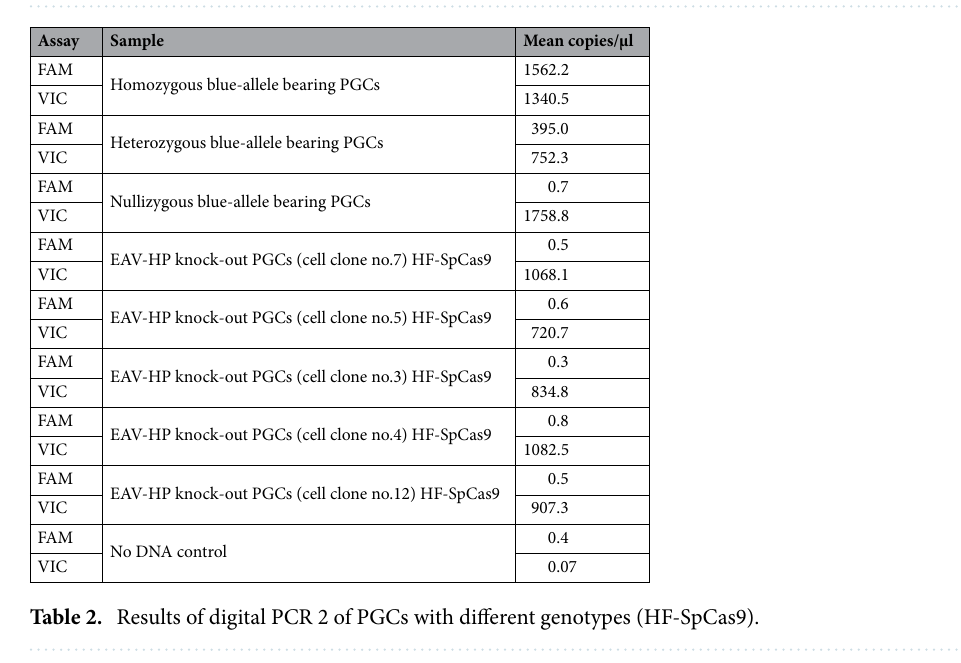
Figure 5. Digital PCR of homozygous blue-allele bearing PGCs and knock-out PGC clones (digital PCR 2). ( a,b,d,e ): blue: FAM reporter dye signal, red: VIC reporter dye signal, green: FAM/VIC reporter dye signals, yellow: no amplification (DNA-empty wells), VIC: reference assay (β-actin), FAM: digital PCR 2 assay. ( a ) Two- dimensional scatterplot of digital PCR duplex assay (FAM/VIC) and ( b ) histogram from PGCs (homozygous blue-allele bearing PGCs); ( c,f ) chip view by calls (uniformity), ( d ) scatterplot of digital PCR duplex assay (FAM/VIC) and ( e ) histogram from a clonal population of knock-out PGCs (homozygous deletion of the entire provirus insertion).